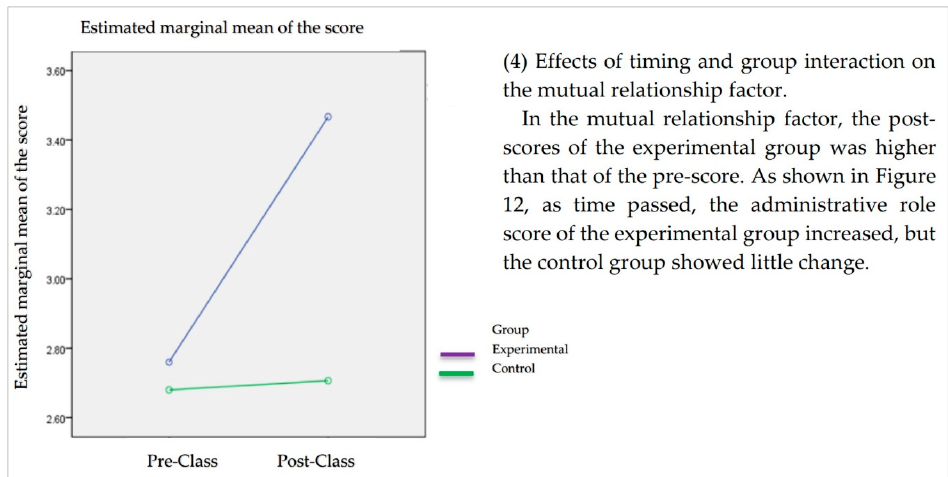
Figure 11. Effect of timing and group interaction on Autonomy. Figure 11. E ff ect of timing and group interaction on Autonomy. Appl. Sci. 2020 , 10 , x FOR PEER REVIEW